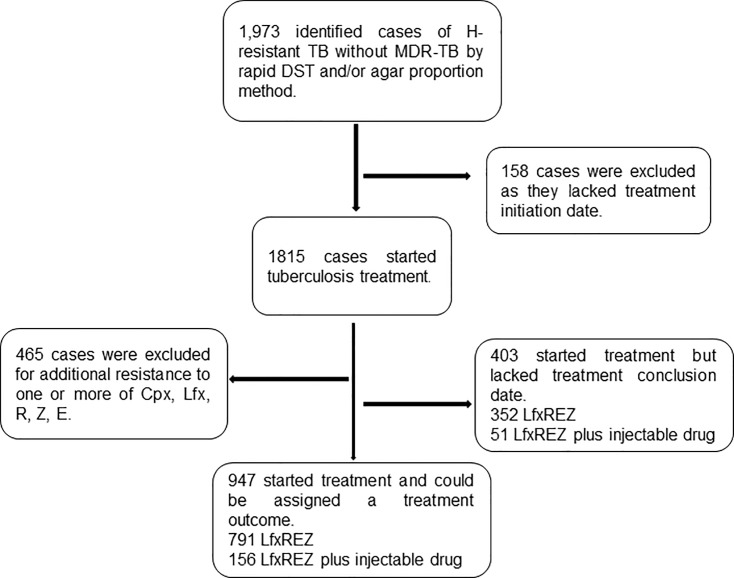
Flowchart for case inclusion.